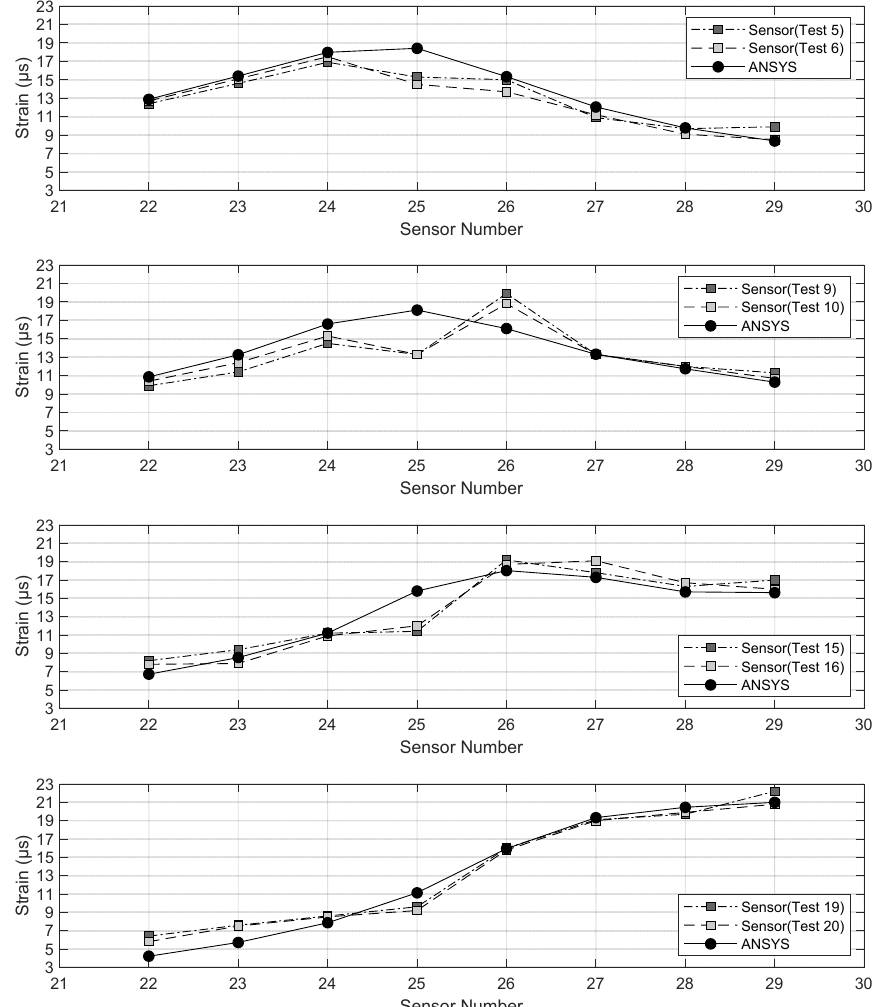
Figure 9. Numerical and empirical strains measured at given gauge locations when the static load (truck with certified weight) was applied to certain locations above span 2.